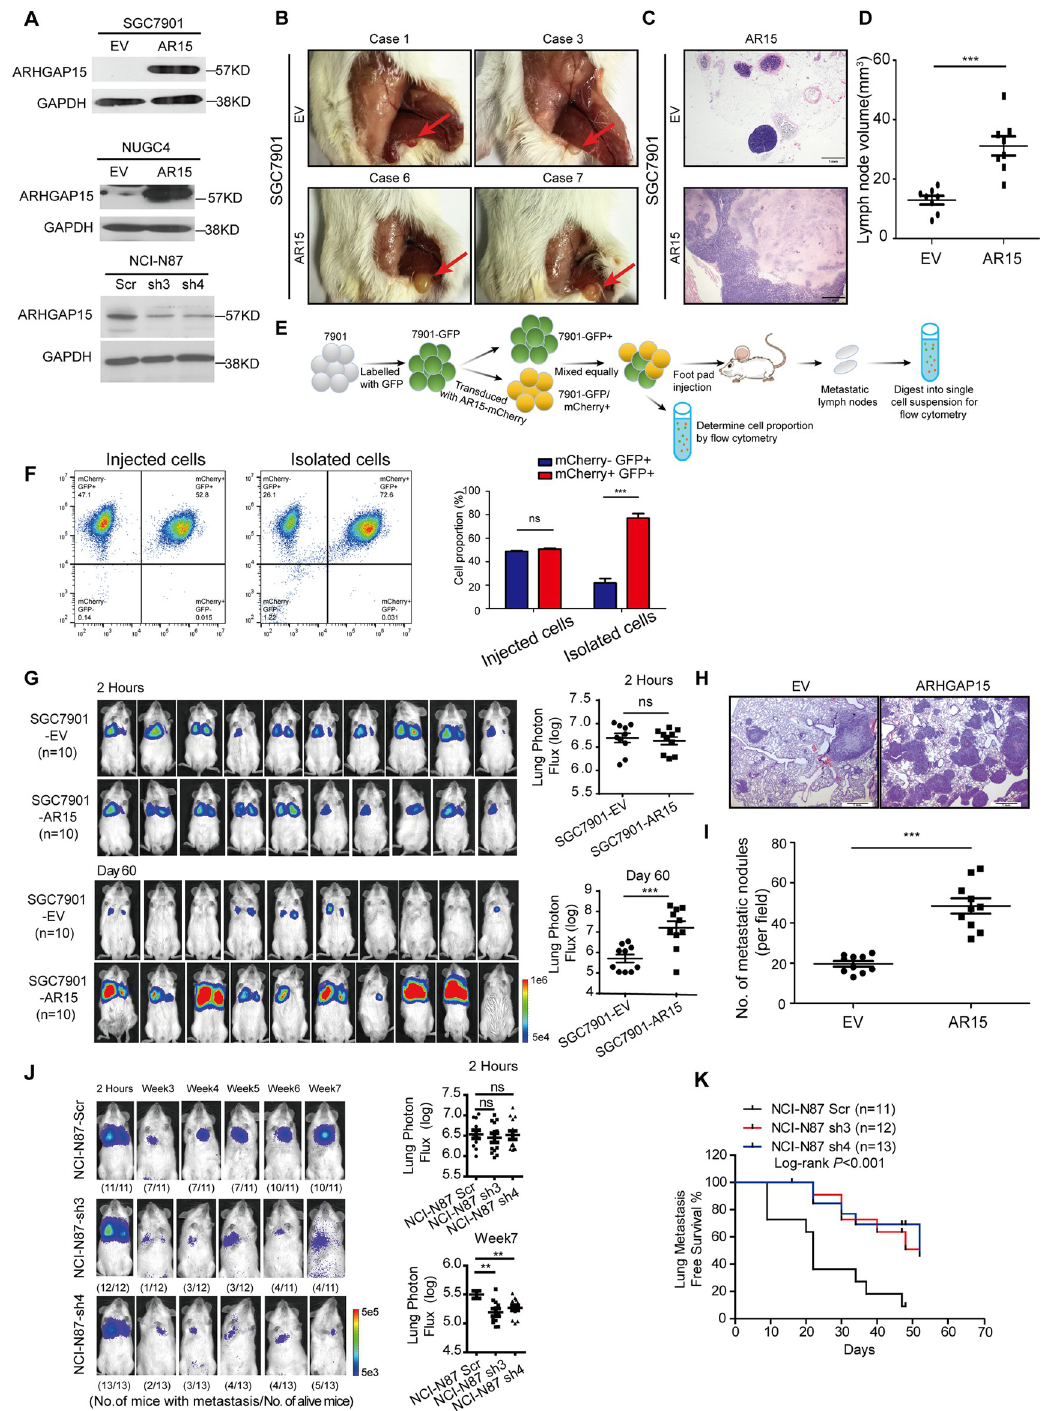
Fig 2. ARHGAP15 enhanced lung metastatic colonization in vivo . (A) : ARHGAP15 expression level was determined by western blot. (B-D) : Spontaneous lymph node metastasis model was established by injection of GC cells into the footpad of mice. 30days after injection, mice were sacrificed to isolate lymph nodes for gross picture taking (B); H&E staining (C) and comparison of lymph node volume (D). (E) : Schematic of experiment design for analyzing cell proportion to explain the mechanism of ARHGAP15 upregulation in metastatic lymph nodes. (F) : The proportion of GFP+ and GFP+/mCherry+ GC cells was determined by flow cytometry with cells collected before footpad injection or isolated from lymph nodes. (G) : SGC7901 cells with or